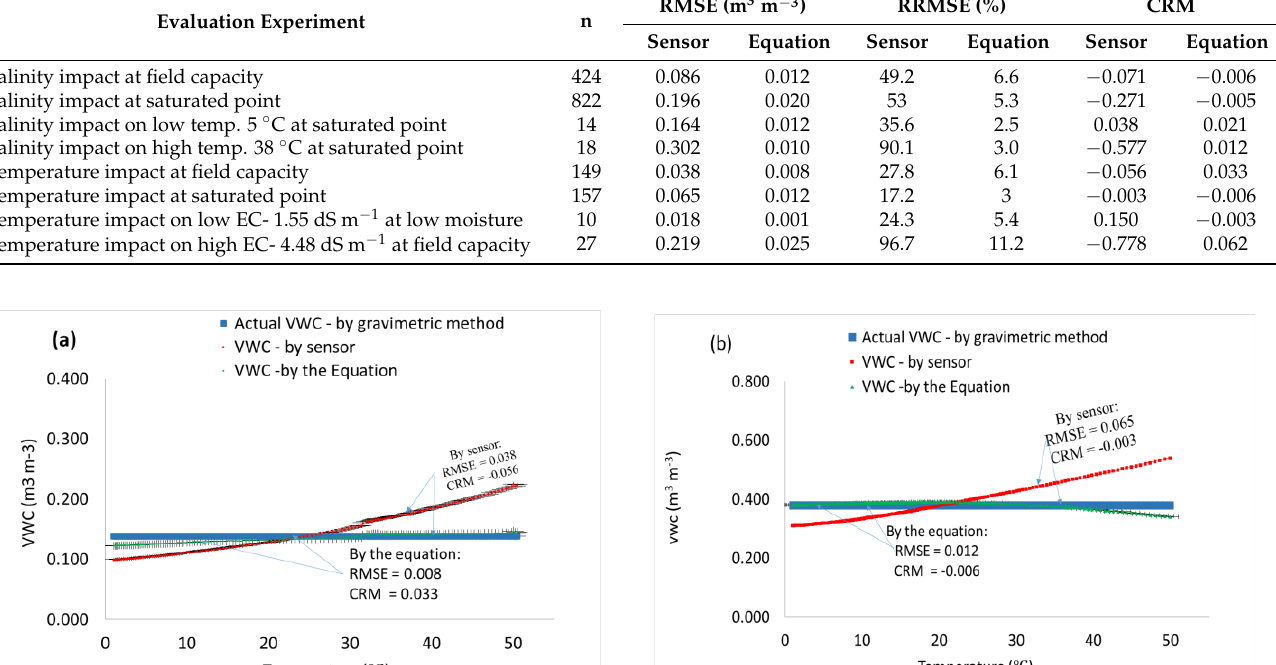
( a ) field capacity moisture and ( b ) saturated